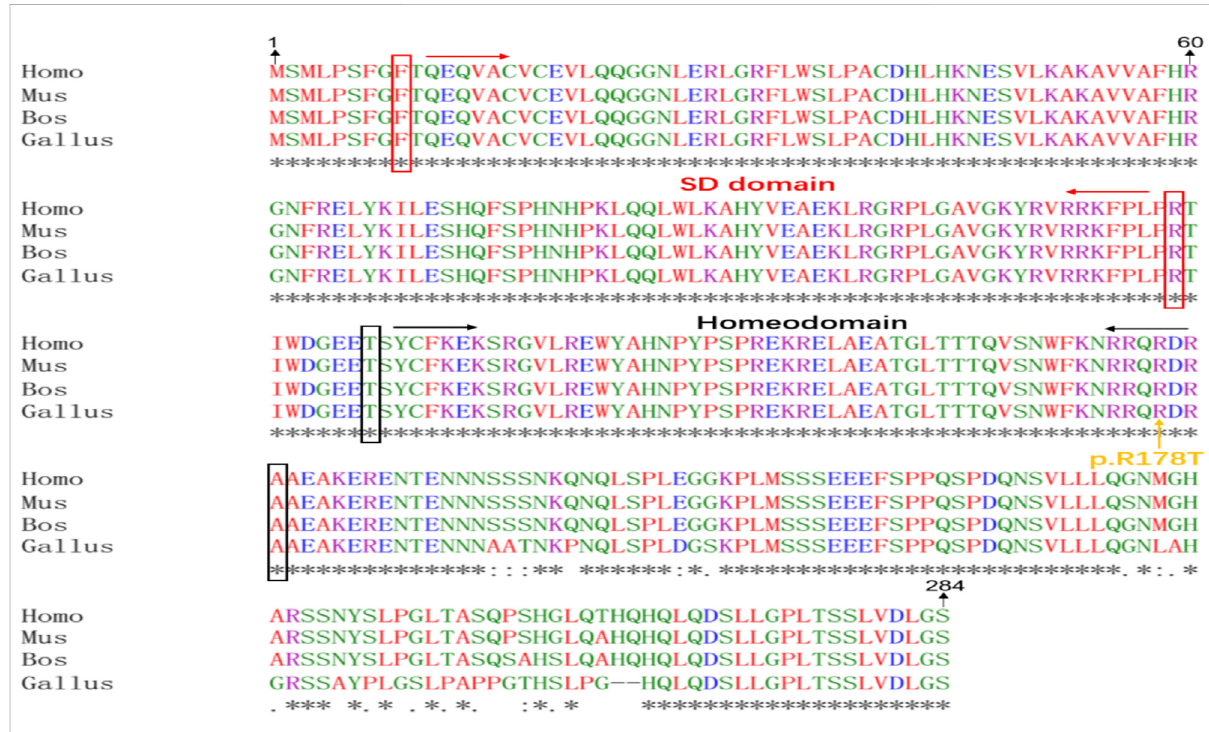
FIGURE 2 Alignment of SIX1 protein sequences from different species. Homo: Homo sapiens (NM_005982.4), Mus: Mus musculus (NM_009189.3), Bos: Bos Taurus (XM_002691019.6), Gallus:Gallus gallus (NM_001044685.2). Red: amino acid containing non-polar and hydrophobic R group, Green: amino acid containing polar and neutral R group, Blue: amino acid containing acidic R group, Purple: amino acid containing basic R group. “ * ” : a completely consistent residue, “ . ” : residues with weak and similar properties, “ : ” : residues with very similar